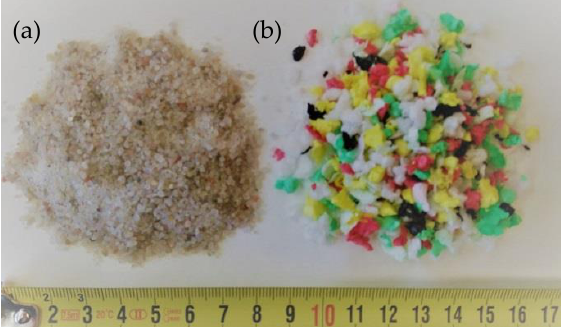
Figure 3. Natural ( a ) and waste-expanded polypropylene-based aggregate ( b ).